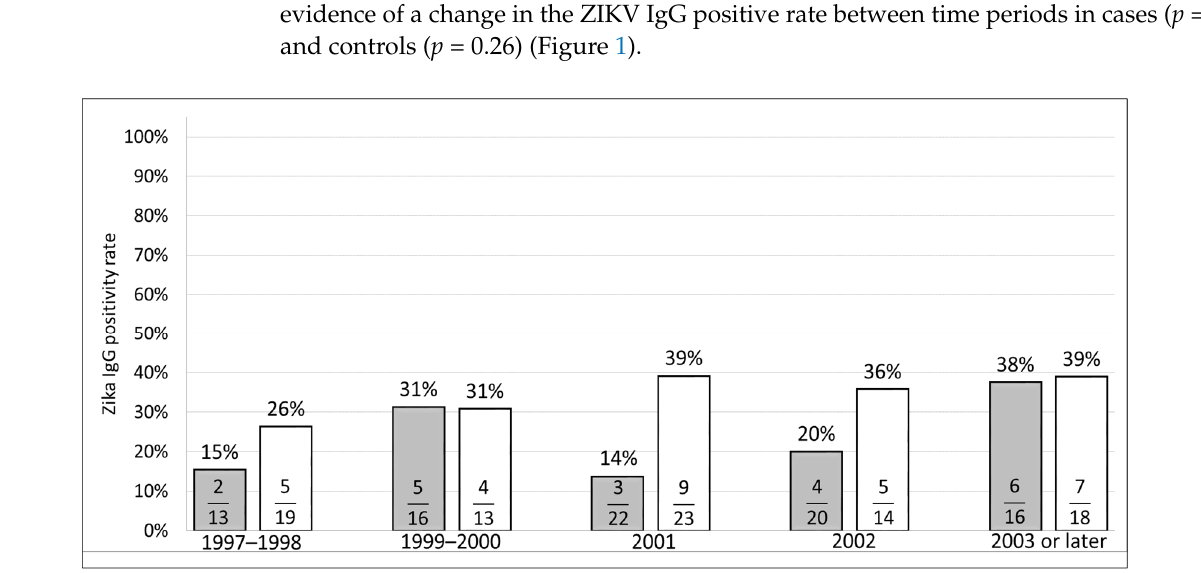
Table 2 . Seroprevalence of Zika and dengue IgG among pregnant women with adverse pregnancy outcomes and controls .